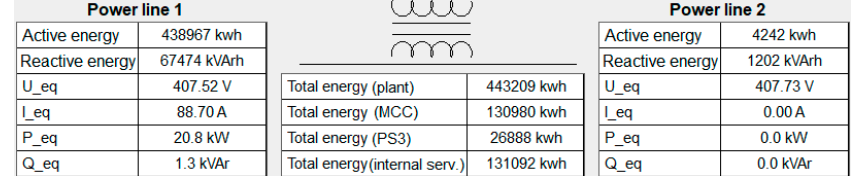
Figure 2. A water treatment plant (WTP).